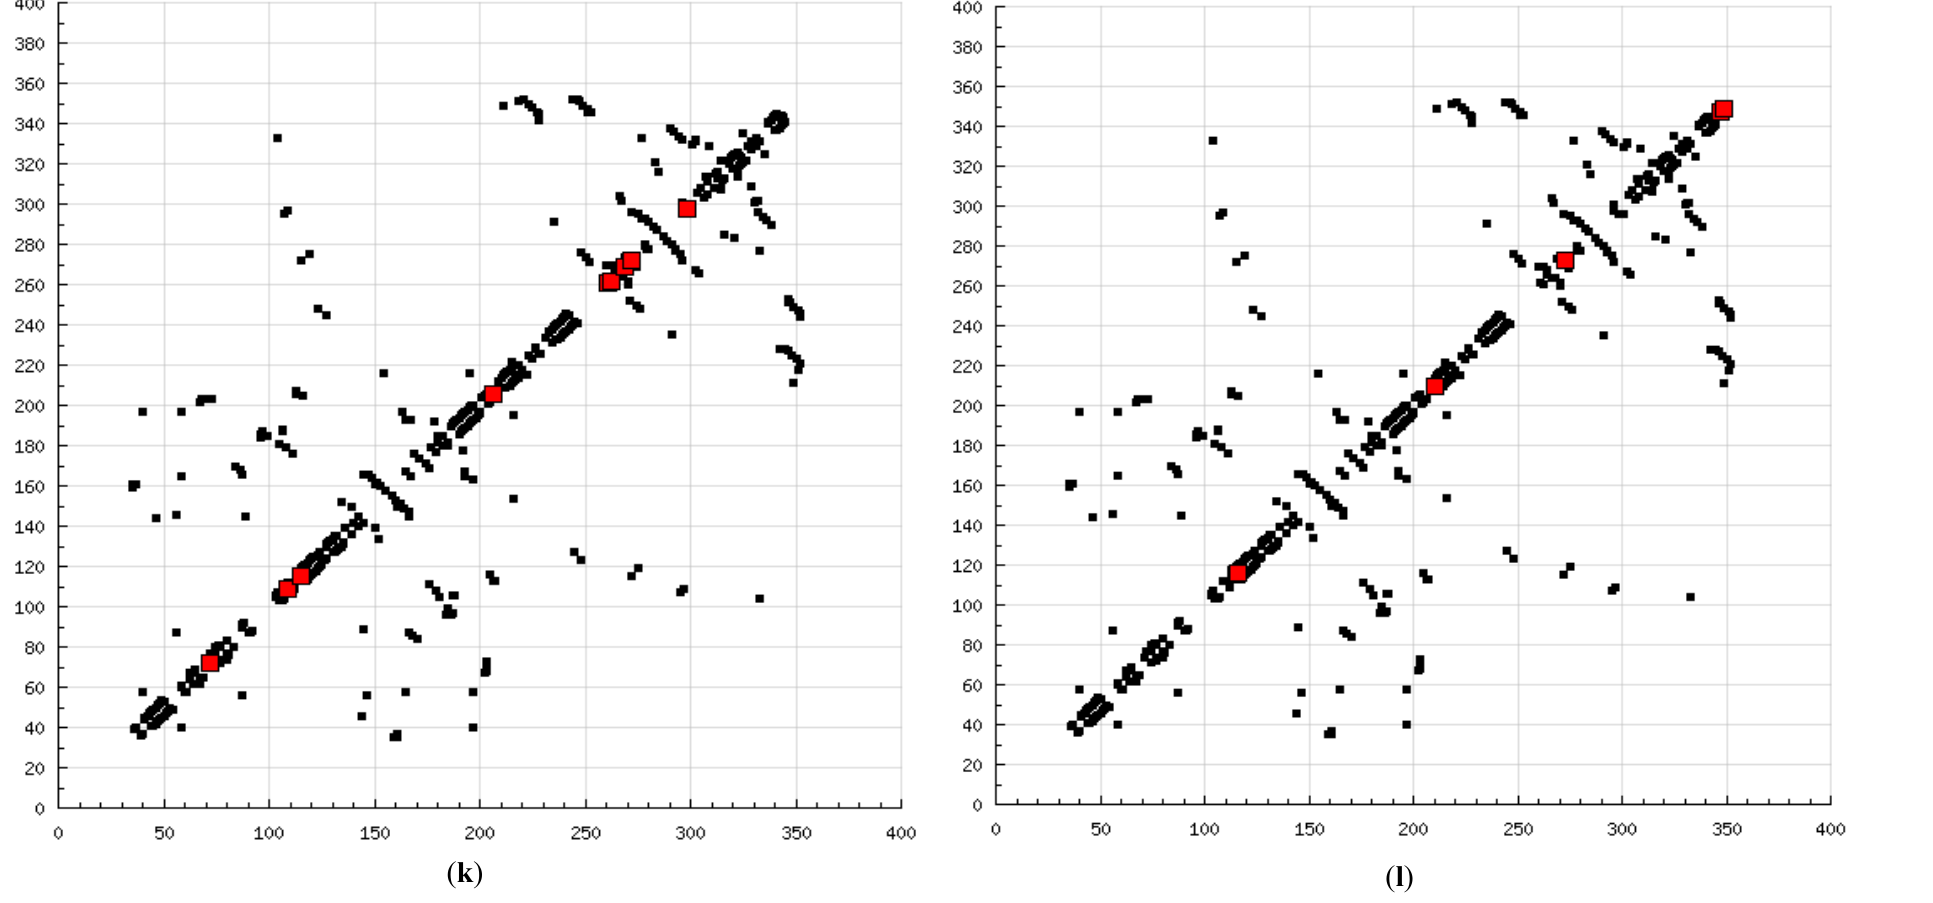
Figure 8. 2D HBPlots indicating the differences in the calpain binding modes between coupled inhibitors employed in this